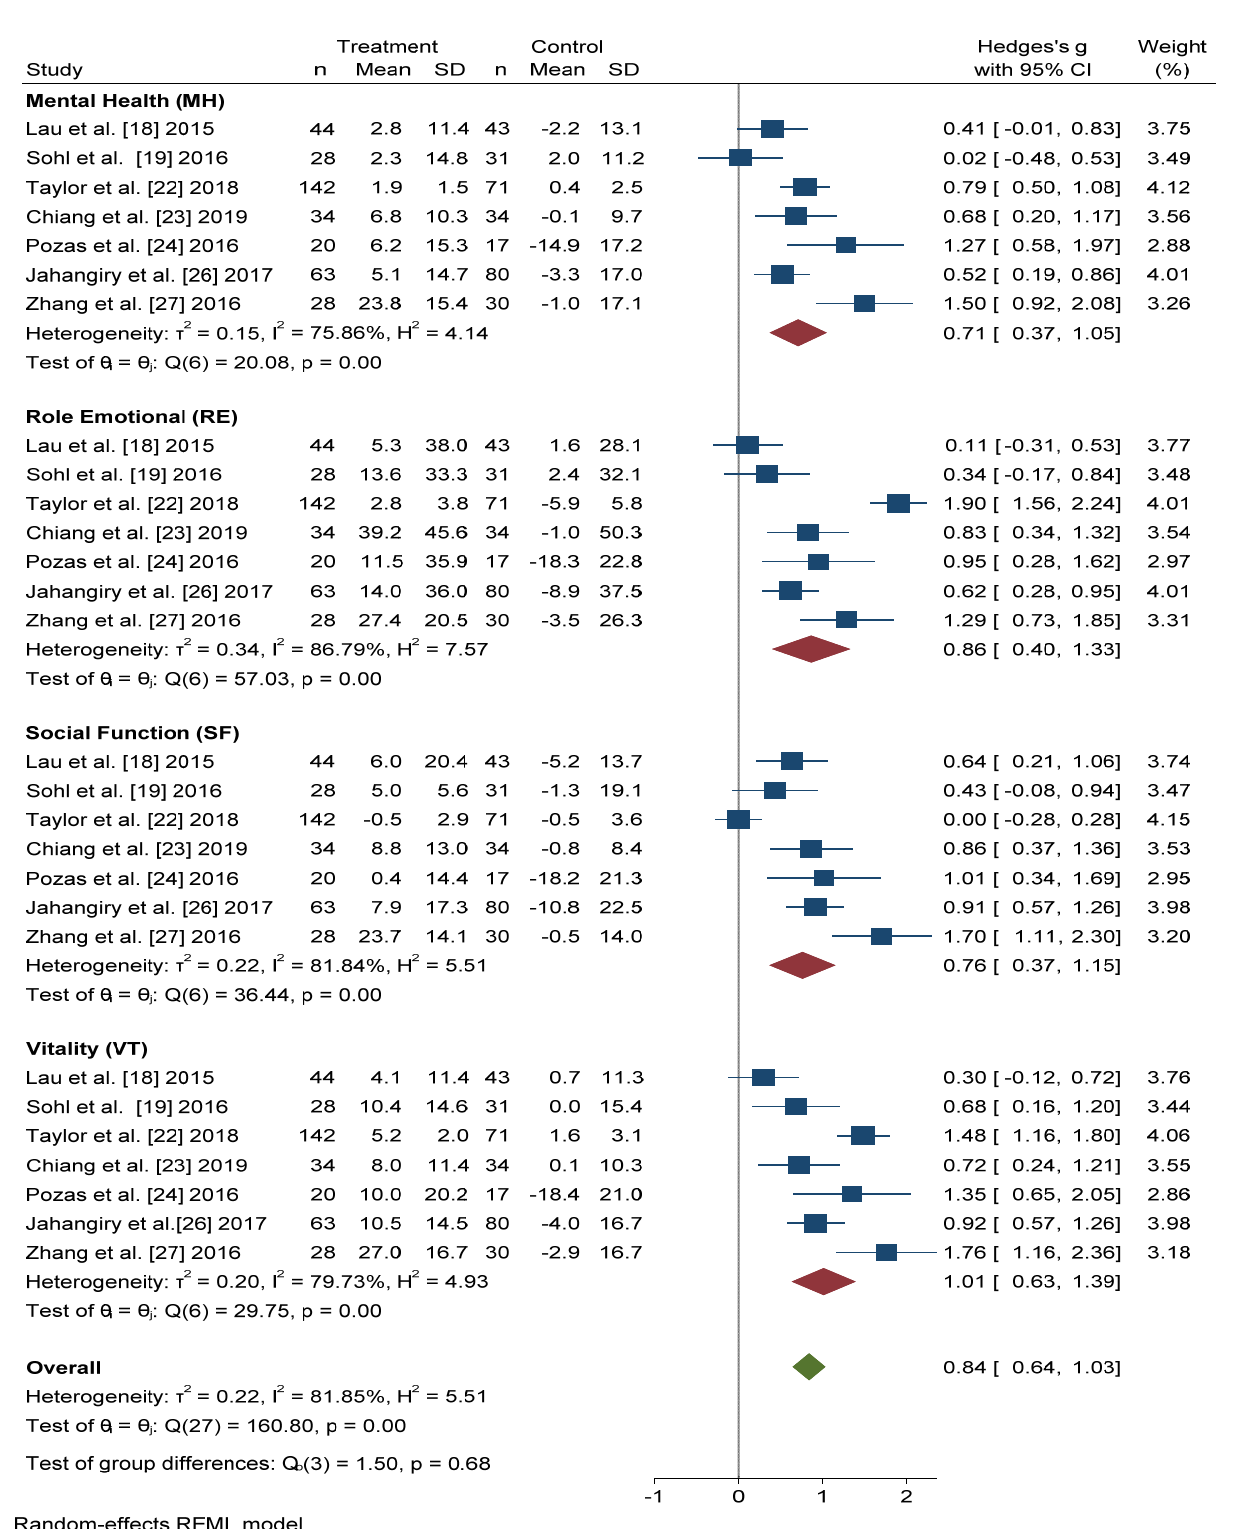
Figure 5. Forest plots of the mental health scores. Blue navy square centered at the point estimate of the effect size, with a horizontal line extending on either side of the square, representing the 95% confidence interval of the point stimate. Red diamond represents a confidence interval for each dimensions and green diamond represents a confidence a confidence interval for the overall effect size. REML: Restricted maximum-likelihood.